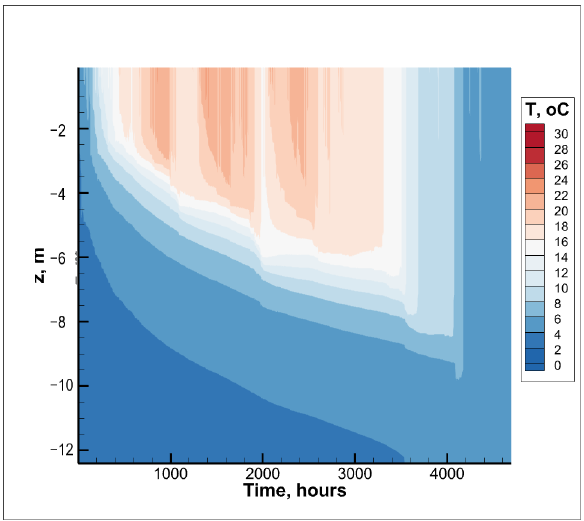
Figure 6. Time–depth distribution of temperature in Kuivajärvi Lake.